Question: Provide a one-line summary of what is displayed.
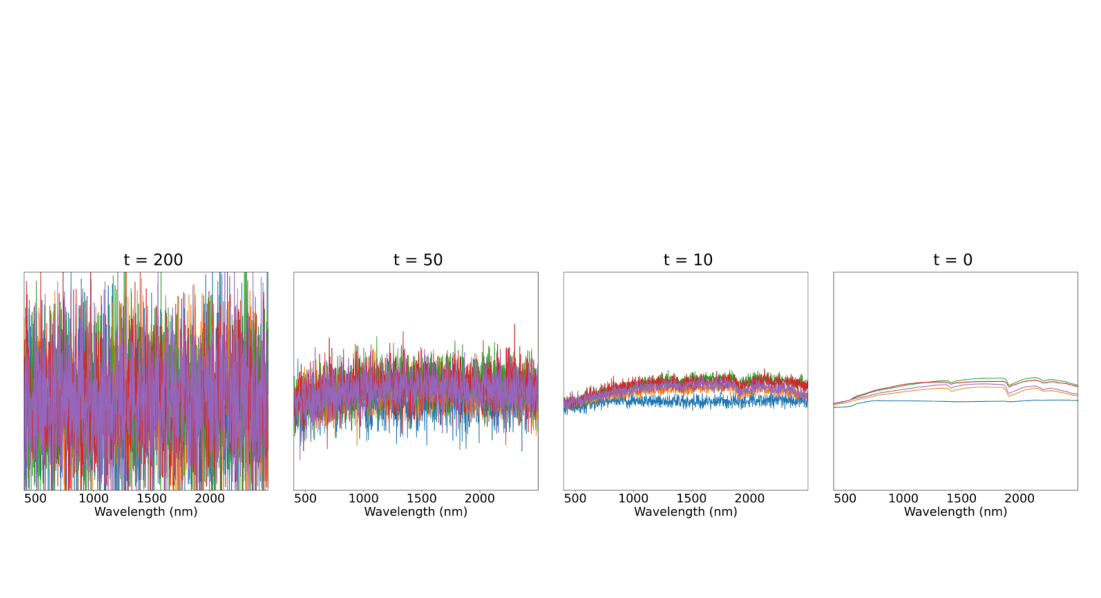
Answer: Example illustration of the spectral denoising process. During the reverse diffusion process, the soil spectra are progressively recovered as the time step decreases. Four example spectra are shown at time steps (t): 200, 50, 10, and 0.